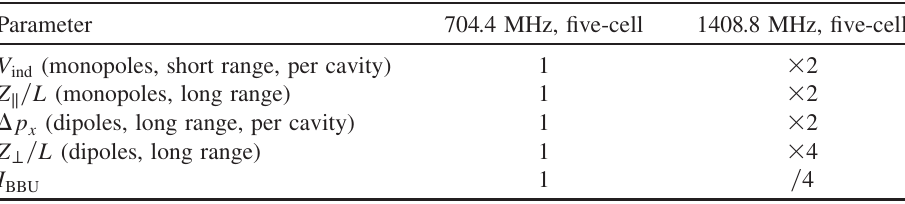
TABLE XIII. HOM parameter scaling for linear frequency scaling (same number of cells). Parameter 704.4 MHz, five-cell